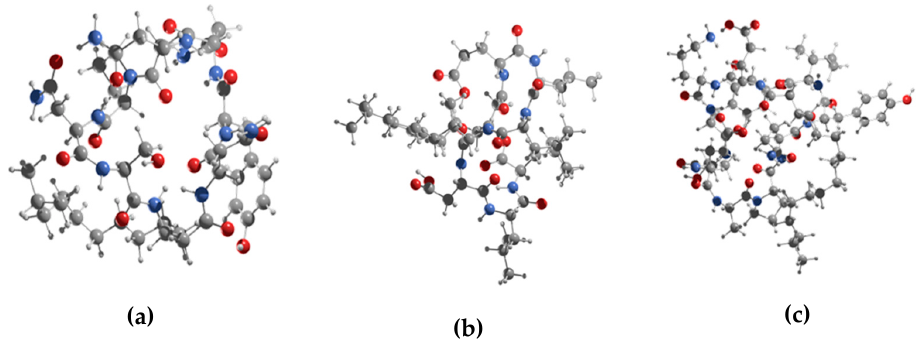
Figure 3. Three-dimensional structural representation of ( a ) iturin A, ( b ) fengycin, and ( c ) surfactin calculated by a homemade code interfaced to Persistence of Vision Ray-tracer (POVRAY.)